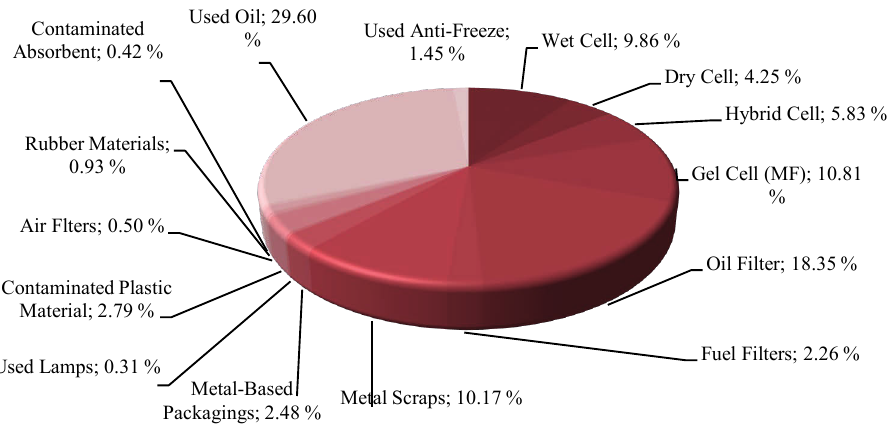
Fig. 2. Waste composition in Bandung City’s licensed